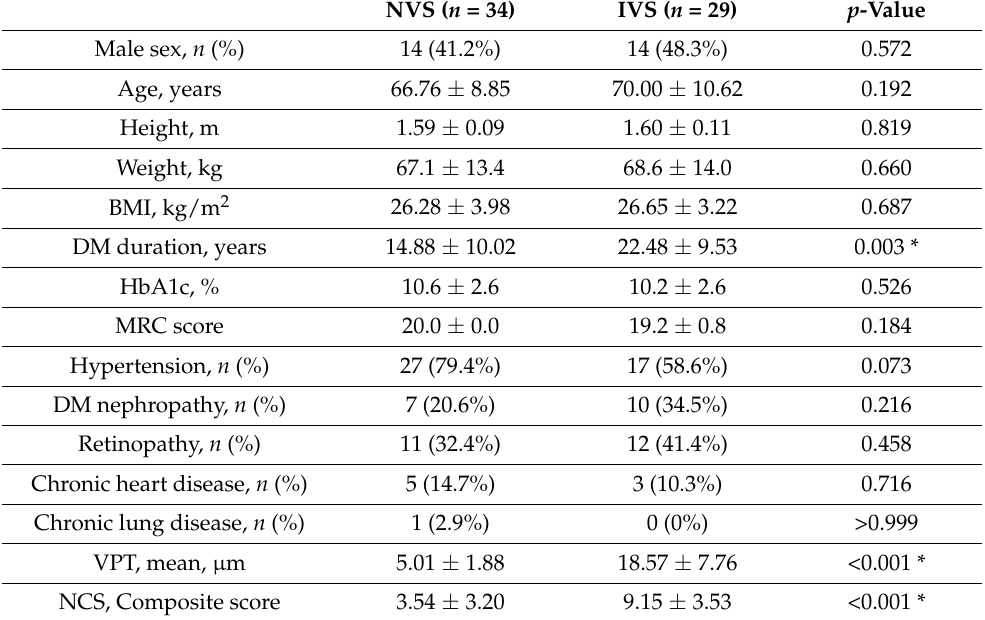
Table 1. Baseline characteristics of patients with type 2